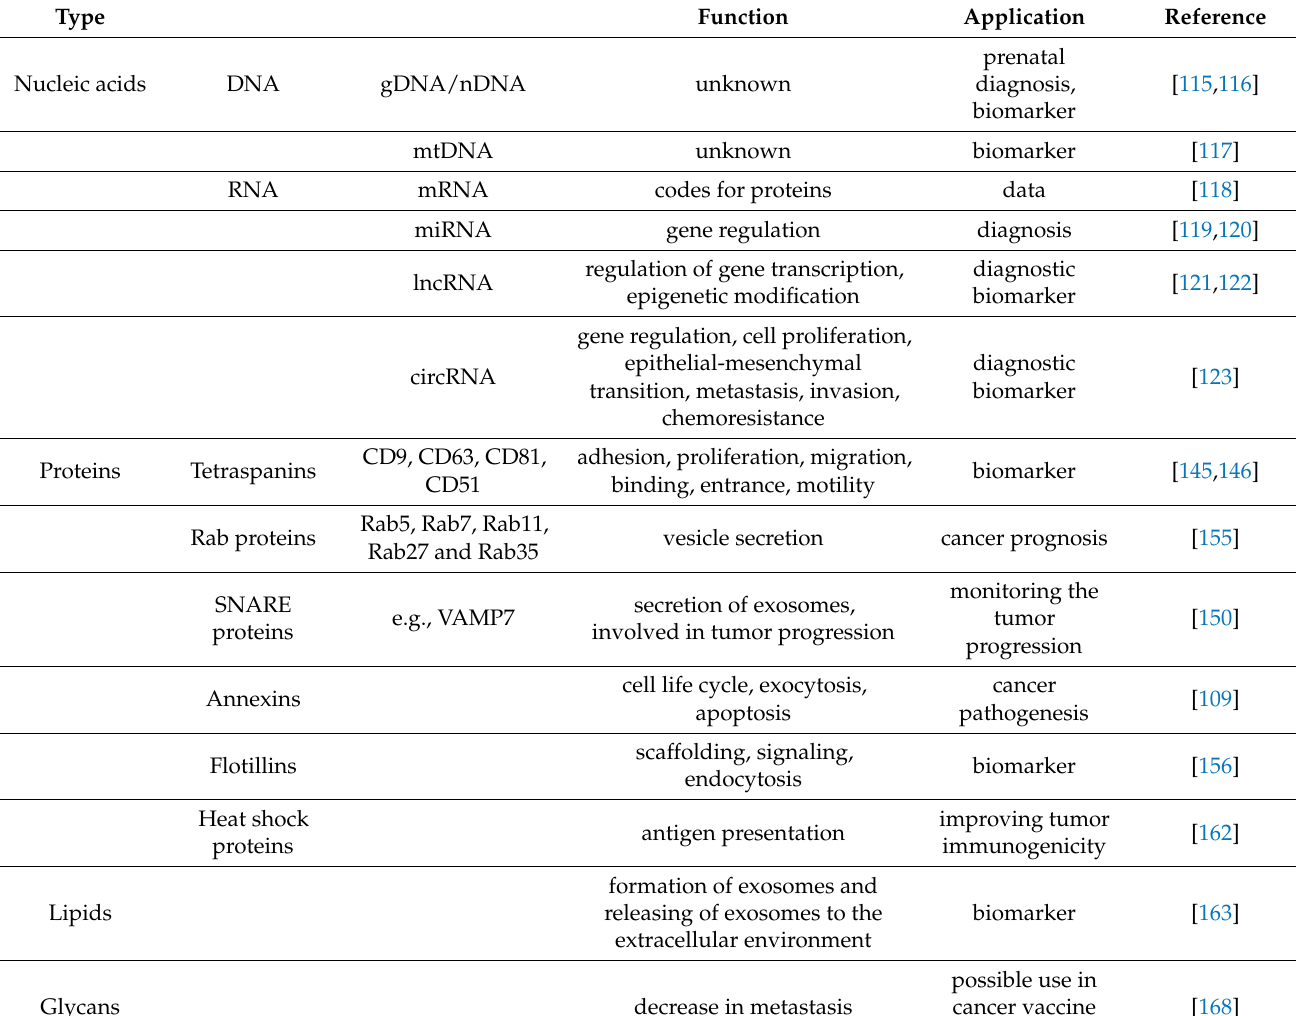
Table 2. A summary of exosome